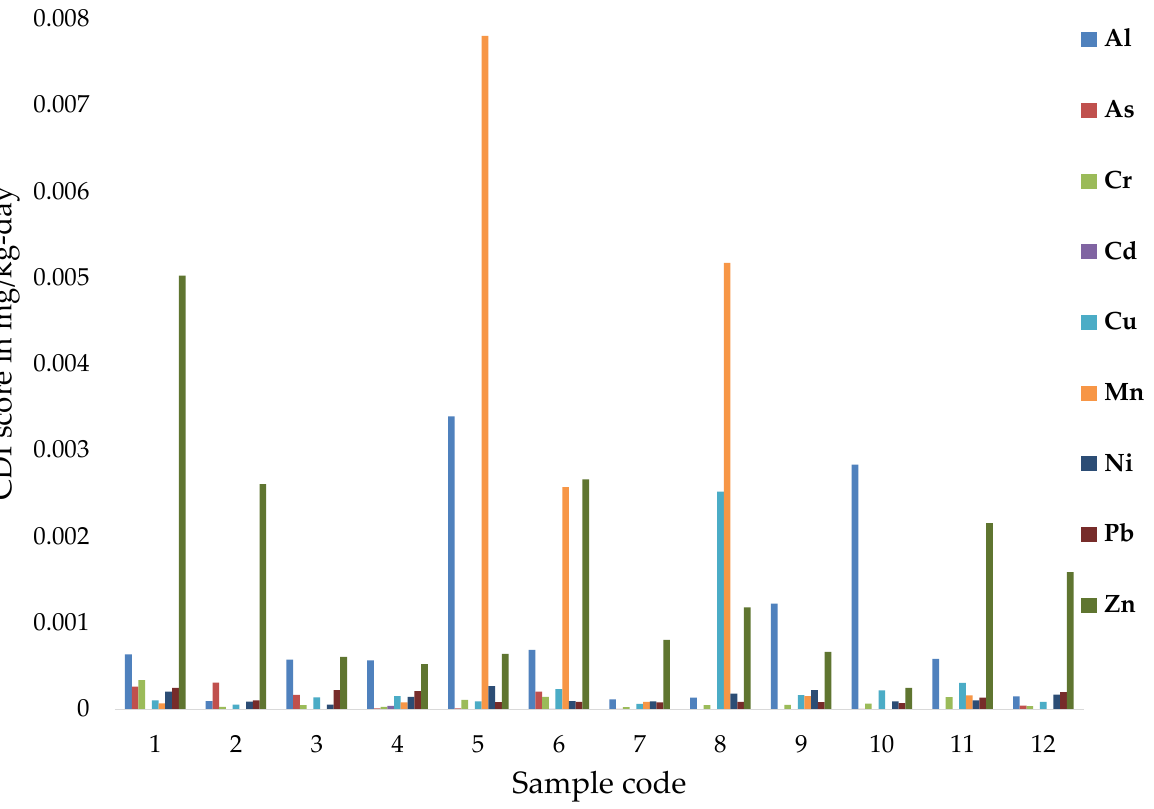
Figure 7. CDI scores obtained for the studied water samples if consumed.